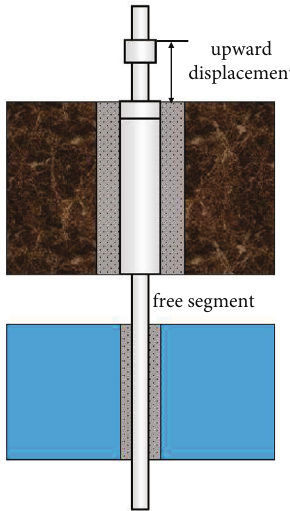
Figure 8: Diagram of well structure of casing